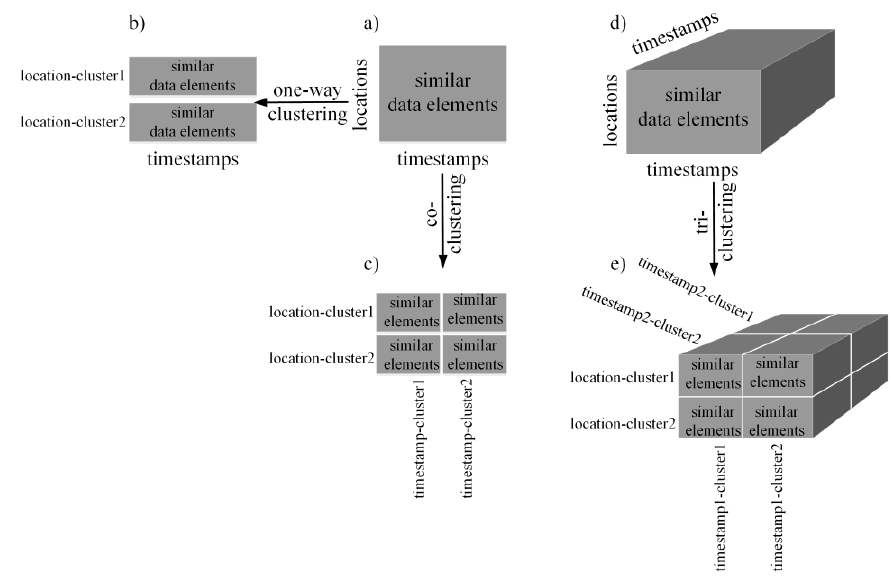
Figure 1. One-way clustering ( a and b ), co-clustering ( a and c ) and tri-clustering ( d and e ) methods.